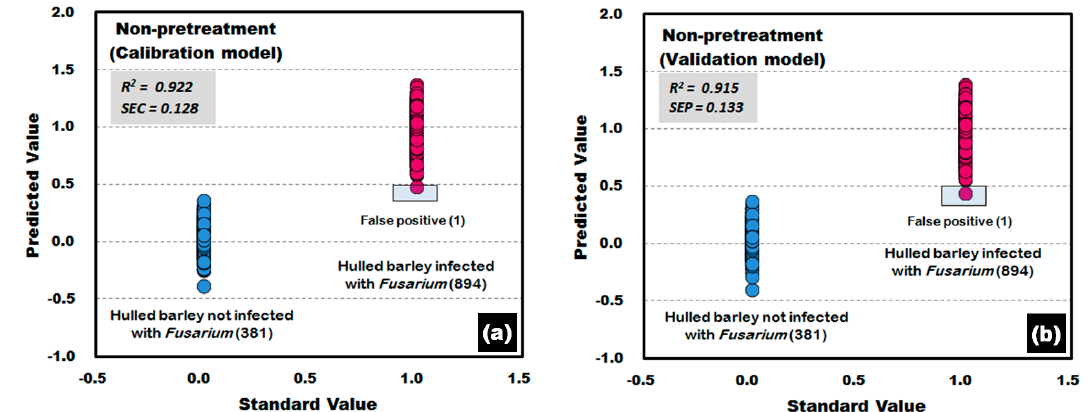
Figure 15. Fusarium discrimination calibration ( a ) and validation ( b ) results of PLS-DA model developed by using the raw reflectance spectra obtained from the back side of hulled barley.